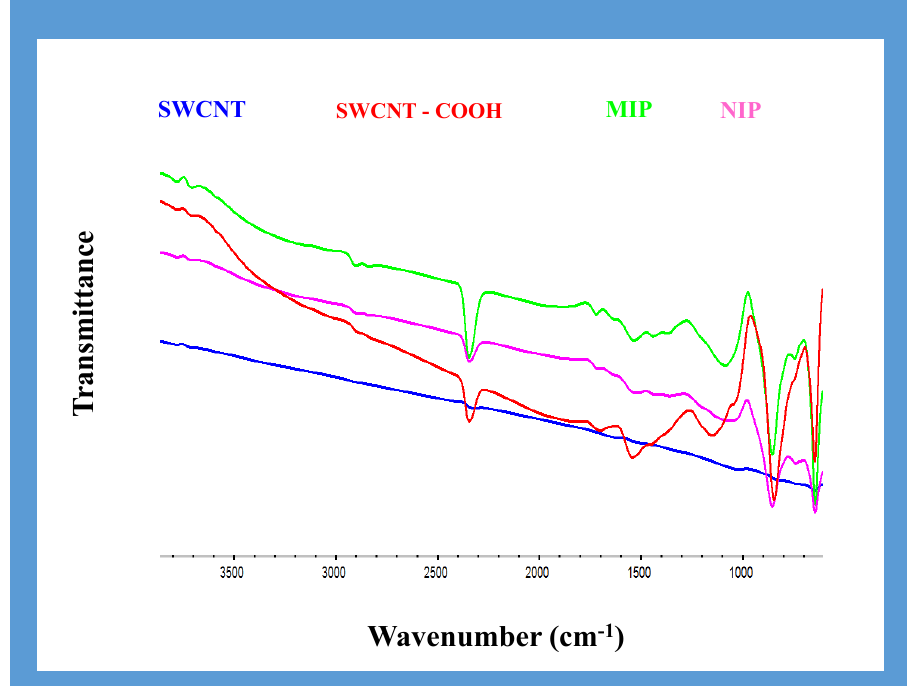
Figure 3. FTIR spectra of SWCNT, CNT-COOH and MIP and NIP.